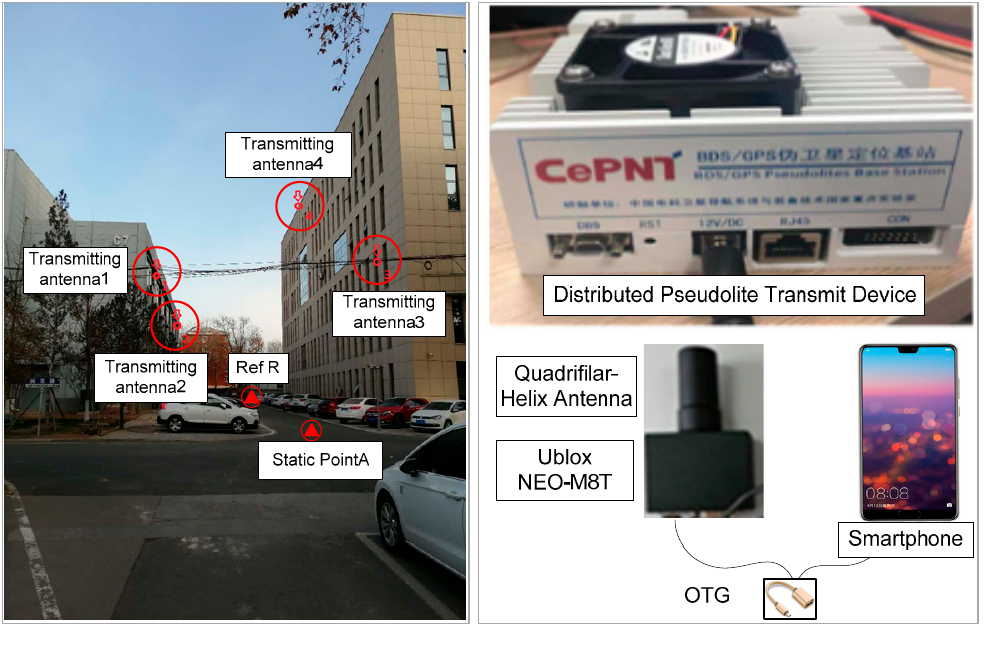
Figure 1. Experimental environments and setup.